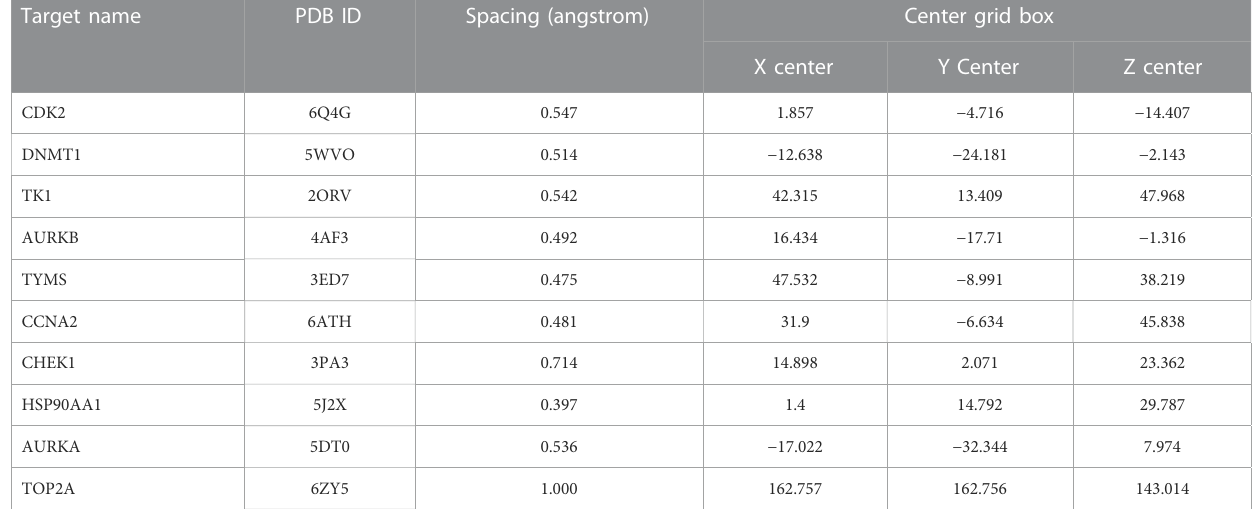
TABLE 3 Grid docking parameters in molecular docking. Target name